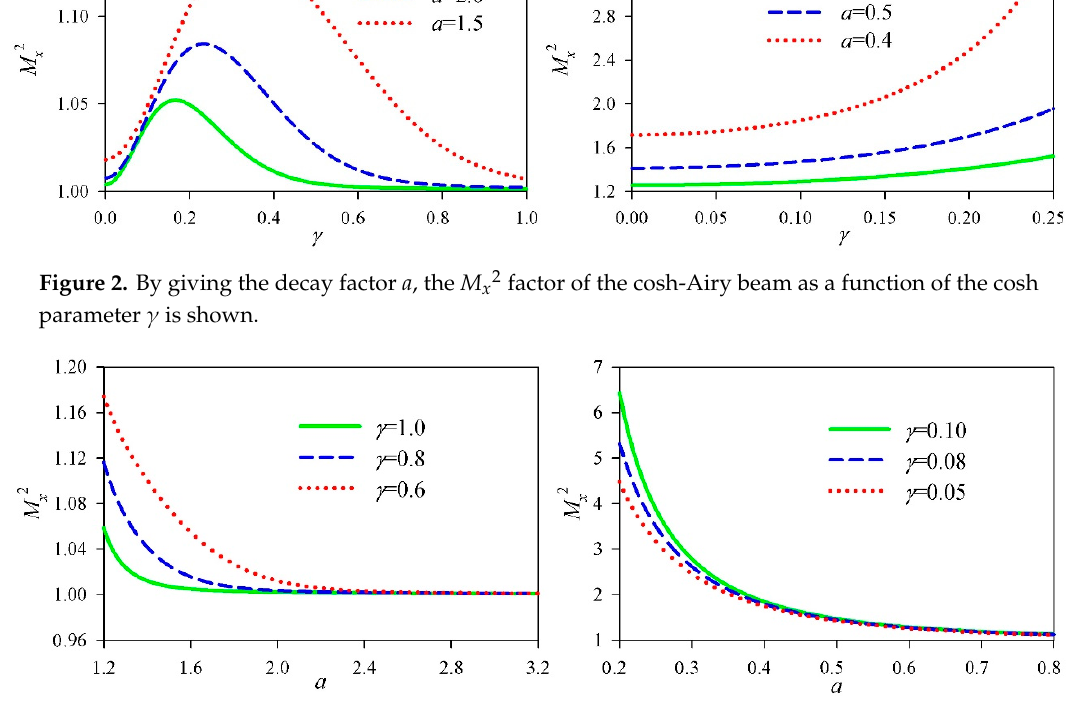
Figure 3. By giving the cosh parameter γ , the M x 2 factor of the cosh-Airy beam as a function of the decay factor a is shown.